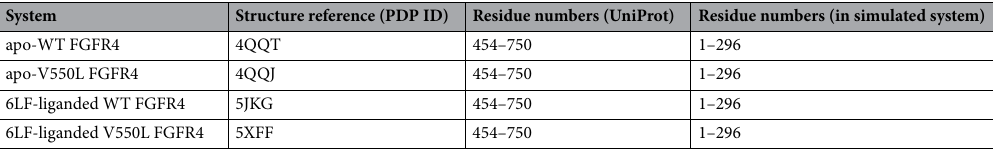
Table 3. FGFR4 systems